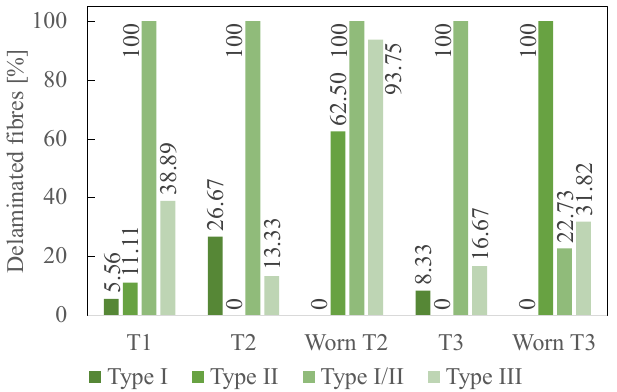
Figure 12. Percentage of delaminated fibres of each delamination type for each cutting tool.